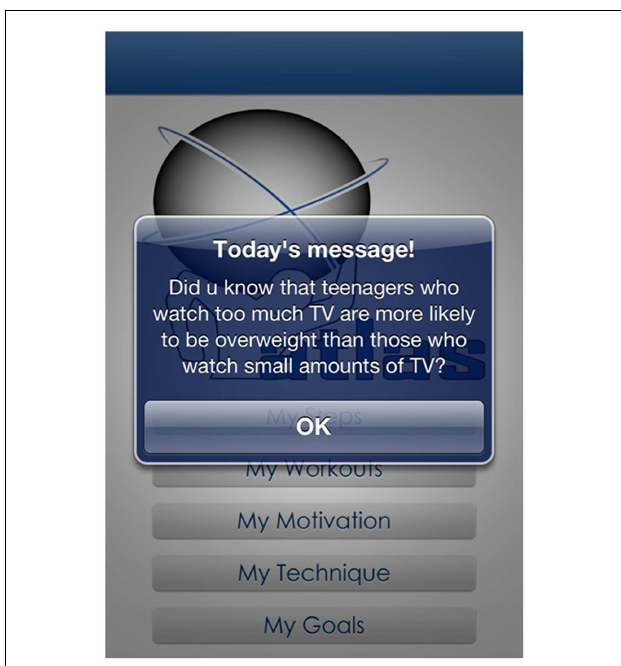
FIGURE 3 | Example-tailored motivational message